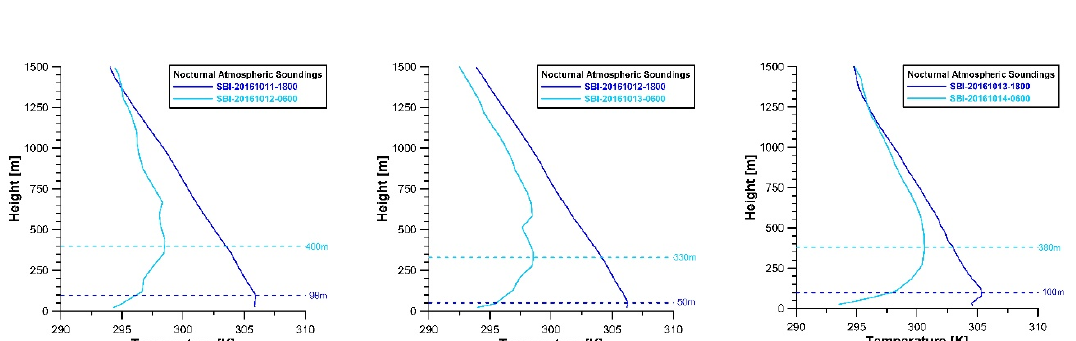
Figure 13. Estimation of the height of the SBL of the Mexicali Valley from the surface-based inversions during the autumn 2016 campaign. The graphs illustrate the change of the SBI from the sunset to 1 h before sunrise of the next day.